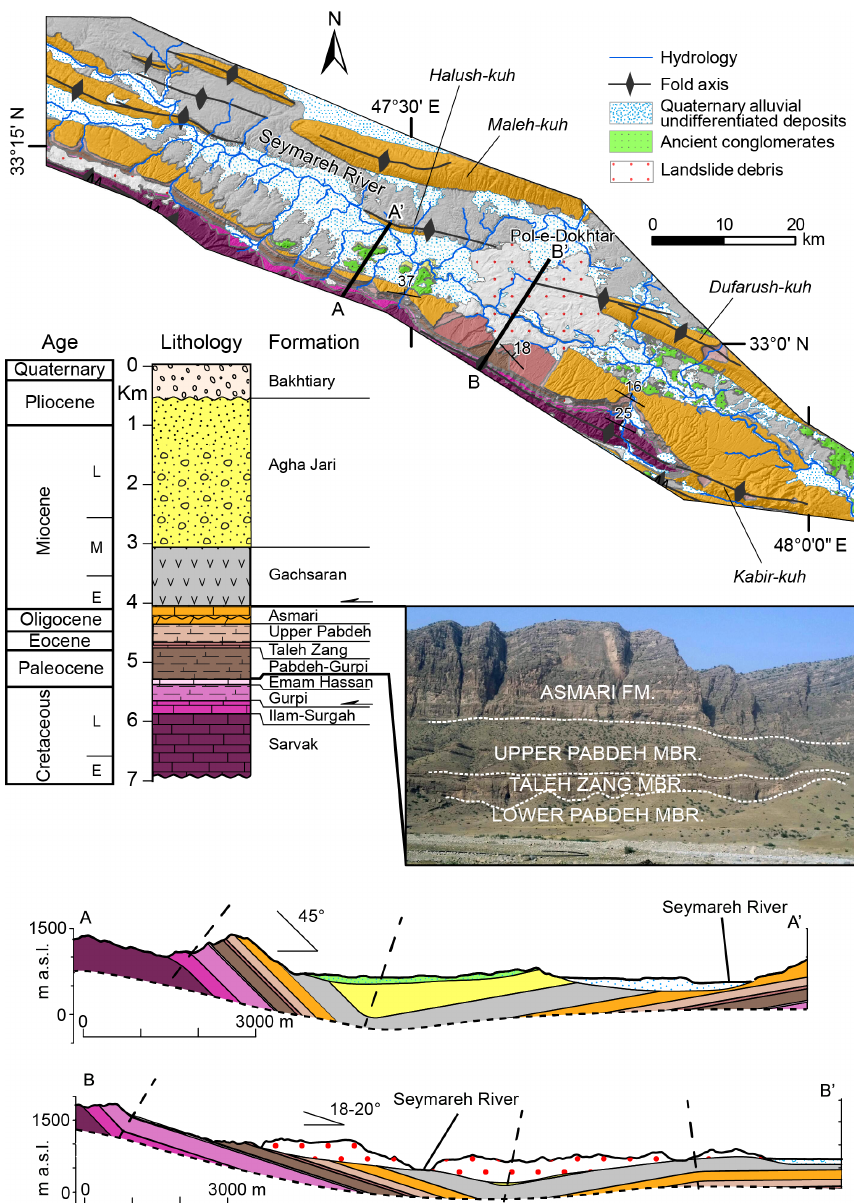
Figure 2. Geological map, stratigraphic column and cross sections of the study